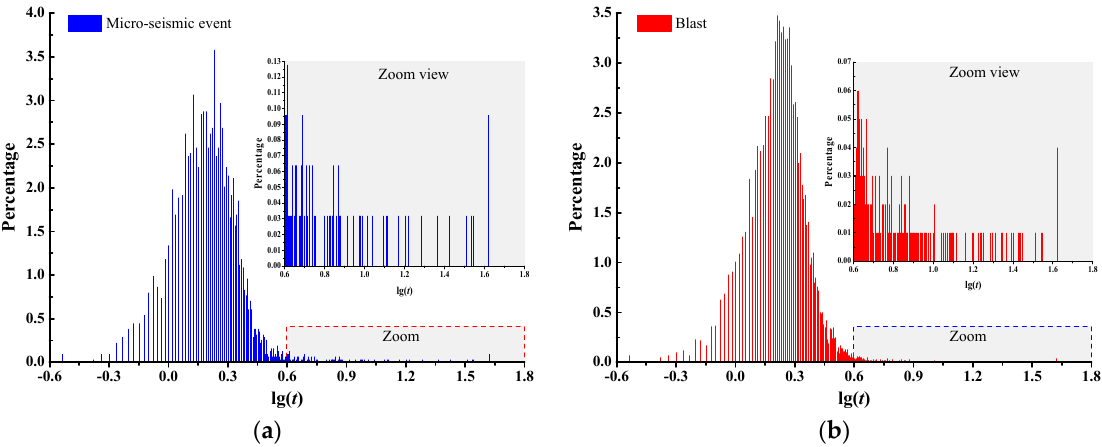
Figure 2. Distributions and percentages of different signal duration for micro-seismic events and blasts. ( a ) Distributions and percentages of signal duration for micro-seismic events; ( b ) distributions and percentages of signal duration for blasts.